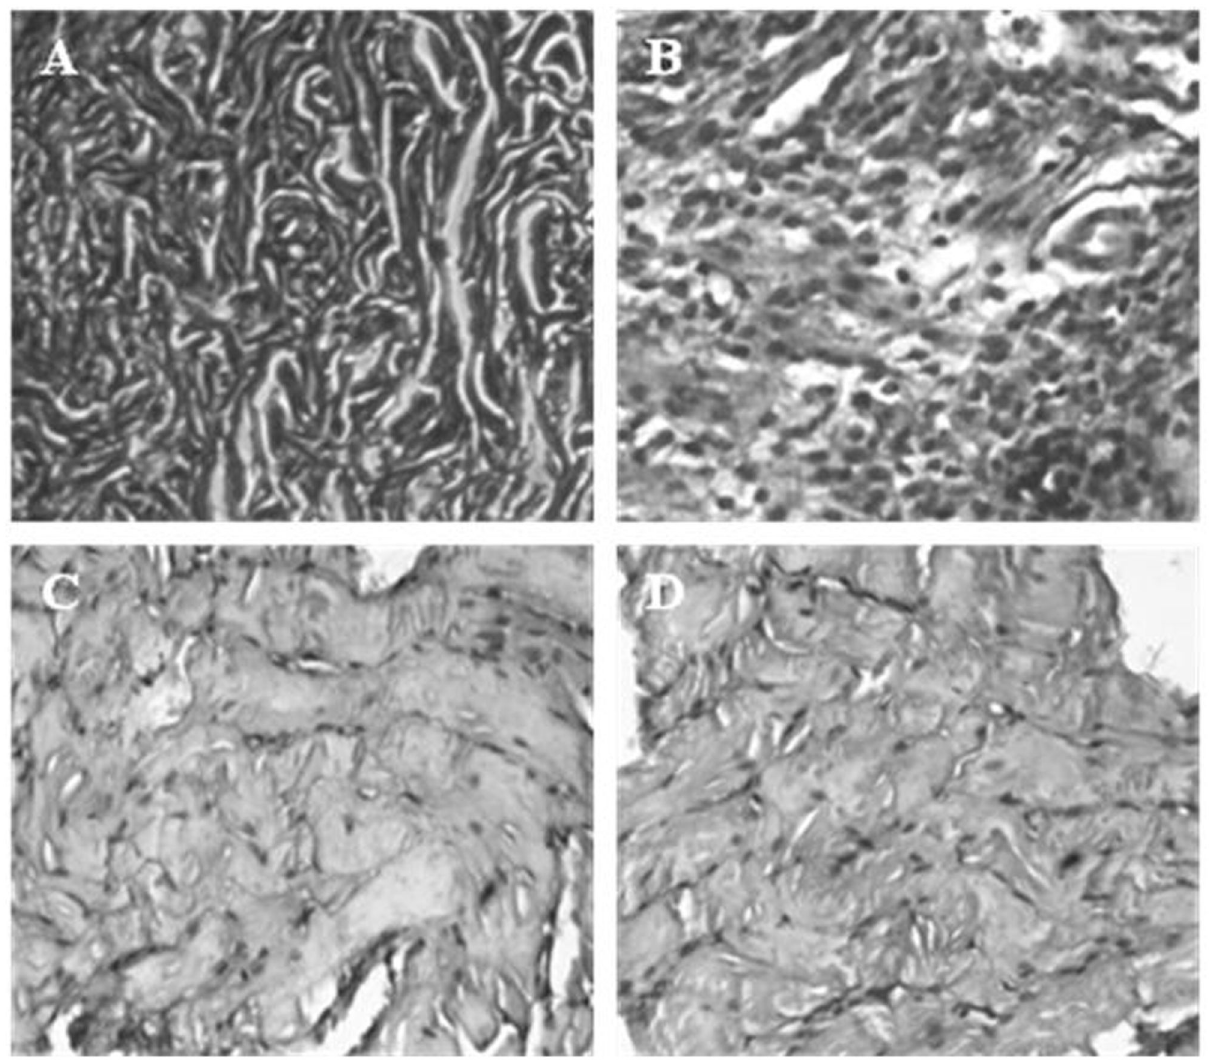
Figure 7. Histopathology of Genital tissue of Balb/C mice. : uninfected [A], infected with HSV-2G [B], HSV-2G infected animals treated with 0.5 µg/ml of HM [C], and ACV at 5 µg/ml